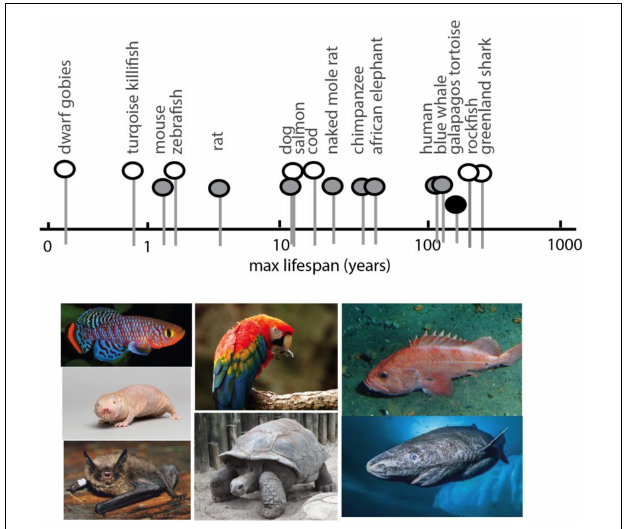
FIGURE 2 | Spectrum of maximum lifespan in vertebrate species: comparative models. Maximum lifespan of select vertebrates showing broad range (over two magnitudes) and diversity. Pictured below are examples of select species exhibiting extreme bounds of lifespan, short to long, for which genomic analysis has been generated. In order, left to right, Turquoise Killifish, Naked Mole Rat (image: National Geographic Creative/Alamy Stock Photo), Brandt’s bat, Scarlet Macaw, tortoise, rockfish, Greenland shark (image: National Geographic). Max lifespan obtained from AnAge